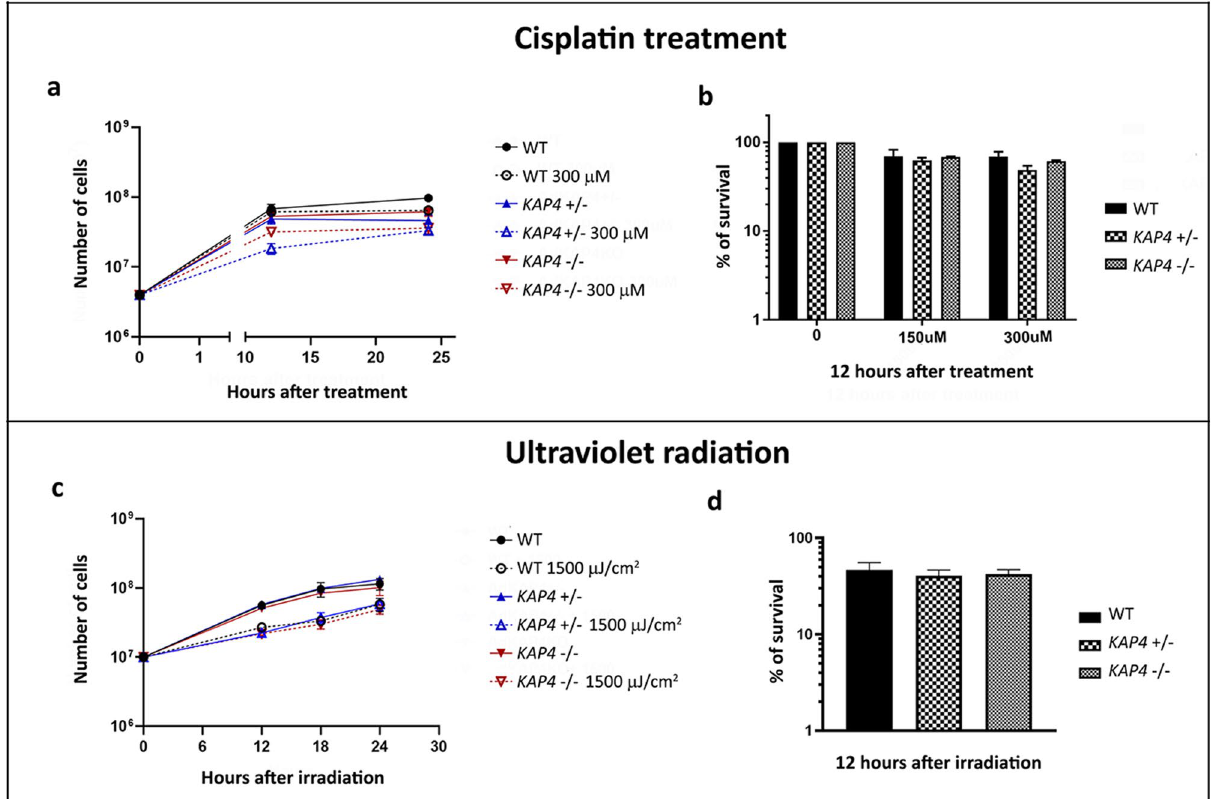
Figure 4. Cell growth and survival after cisplatin treatment or UV radiation. After 12 h, no remarkable differences were observed in cell proliferation and survival when comparing WT and mutant protozoa after treatment with 150 μM and 300 μM cisplatin ( a , b ) or exposure to UV radiation ( c , d